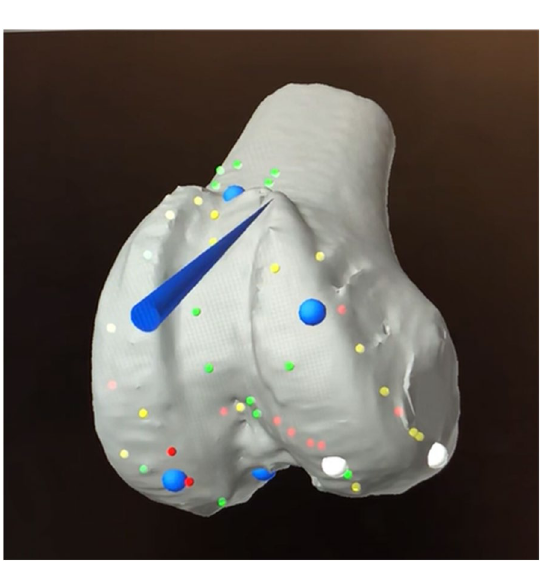
Fig. 5 Femoral bony landmark registration with a total knee femoral component in